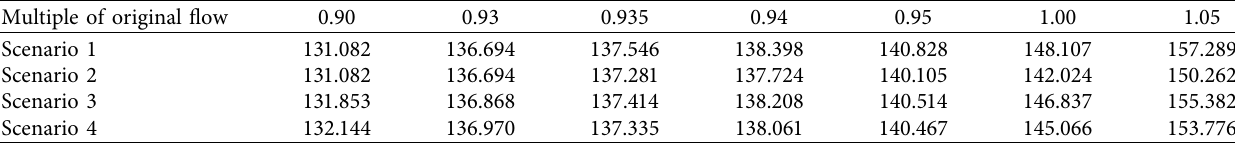
Table 3: TTT (hours) under different traffic